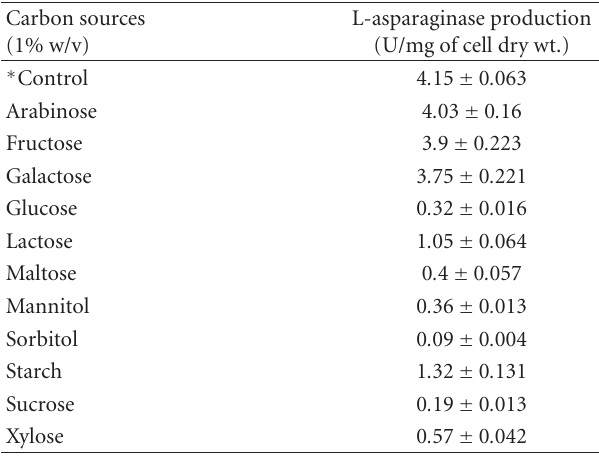
Table 2: Carbon levels on L-asparaginase production by Nocardia levis in modified ISP-5 broth.